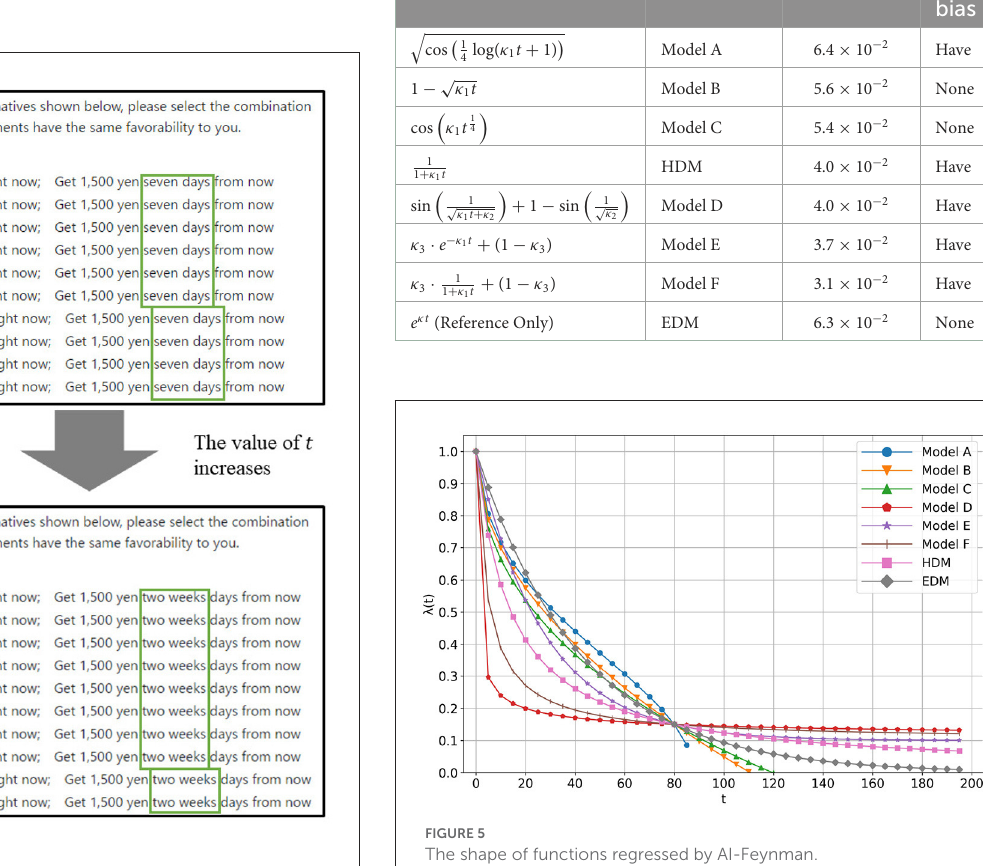
FIGURE3 Example of questionnaire’s first two steps.